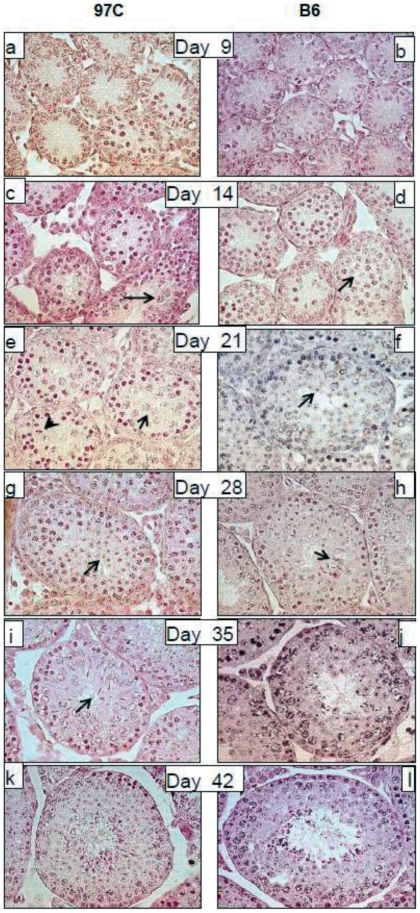
Impaired progression in the first wave of spermatogenesis in juvenile 97 C and B6 parental mice.A representative picture of seminiferous tubule histology of testes from 97 C (a,c,e,g,i,k) and B6 (b,d,f,h,j,l) mice at post natal day 9, 14, 21, 28, 35 and 42 is shown (objective ×60). At day 9 and 14, no difference was found between B6 and 97 C tubule cell population. A germ cell progression up to pachytene spermatocytes (arrows) was observable in both 97 C (c) and B6 (d) testes. At day 21, meiosis was completed and round spermatids (arrow in f) appeared in the tubule of B6, while spermatogenesis of 97 C was still in the meiotic phase with mostly germ cells at pachytene spermatocyte (arrow in e) or metaphase stage (arrow head in e). In addition, at this age, the lumen of the tubules was visible only in B6 mice. At day 28, spermatogenesis normally progressed in B6 up to the elongated spermatid stage (arrows in h) but displayed a one week delay in 97 C testes, where round spermatids (arrow in g) were the most advanced stage of germ cells present in the tubules. Elongated spermatids were not observed before the fifth week in post-natal testis of 97 C (i). Figures of spermiation seen at day 35 in control testes (h) signed the end of the first wave of spermatogenesis in B6 mice, which was only attained at the sixth week in 97 C mice (k). From this time, testis histology of the two strain was comparable (k and l) but a smaller tubule diameter was noticeable for the 97 C testis.